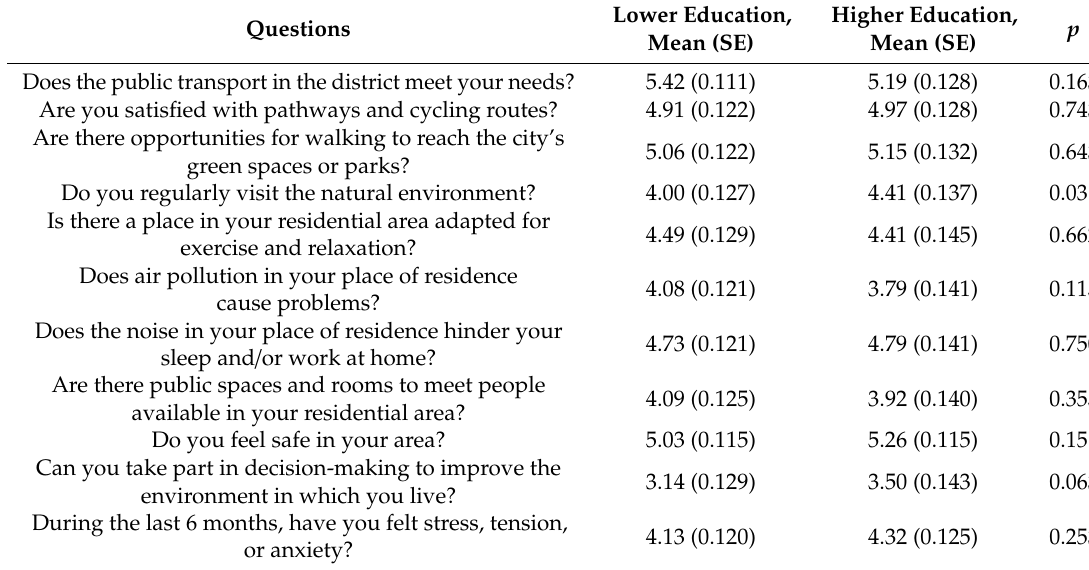
Table 3. Mean ratings of the perceptions of neighborhood quality and social well-being by the education